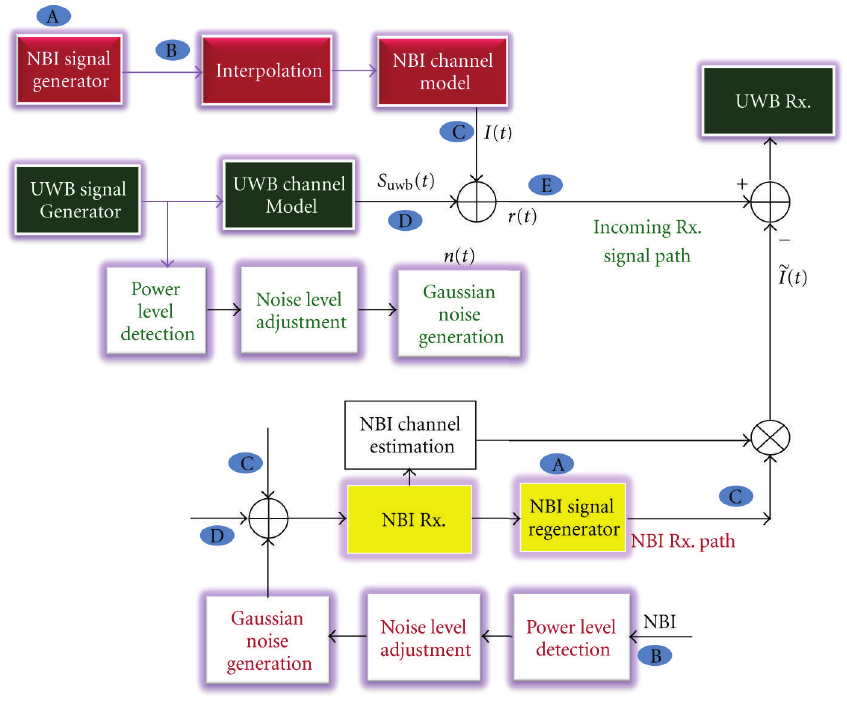
Figure 2: Simulation block diagram of the proposed canceller